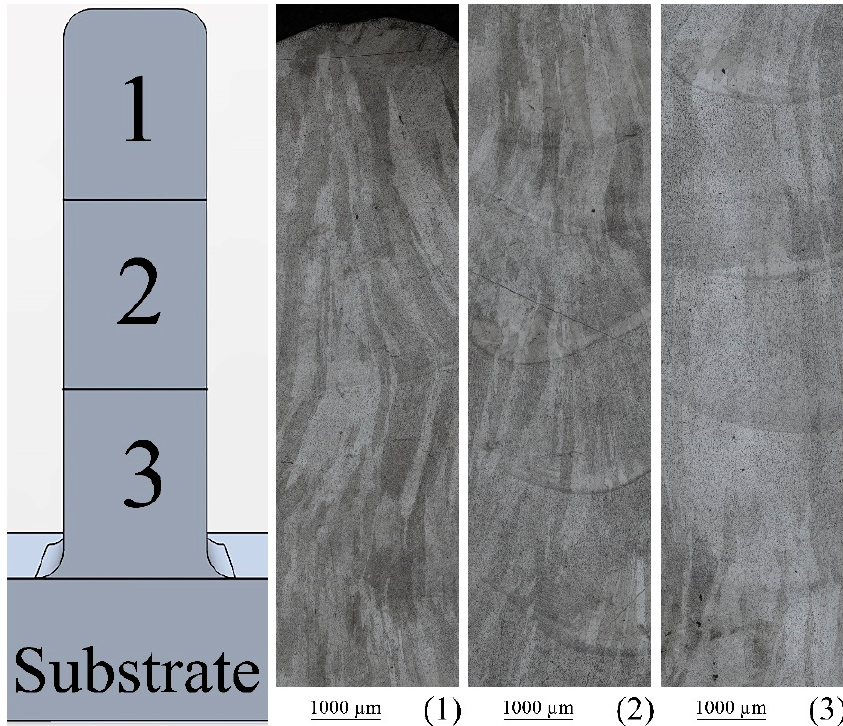
Figure 2. Macrostructure of NiTi WAAM-built metal.